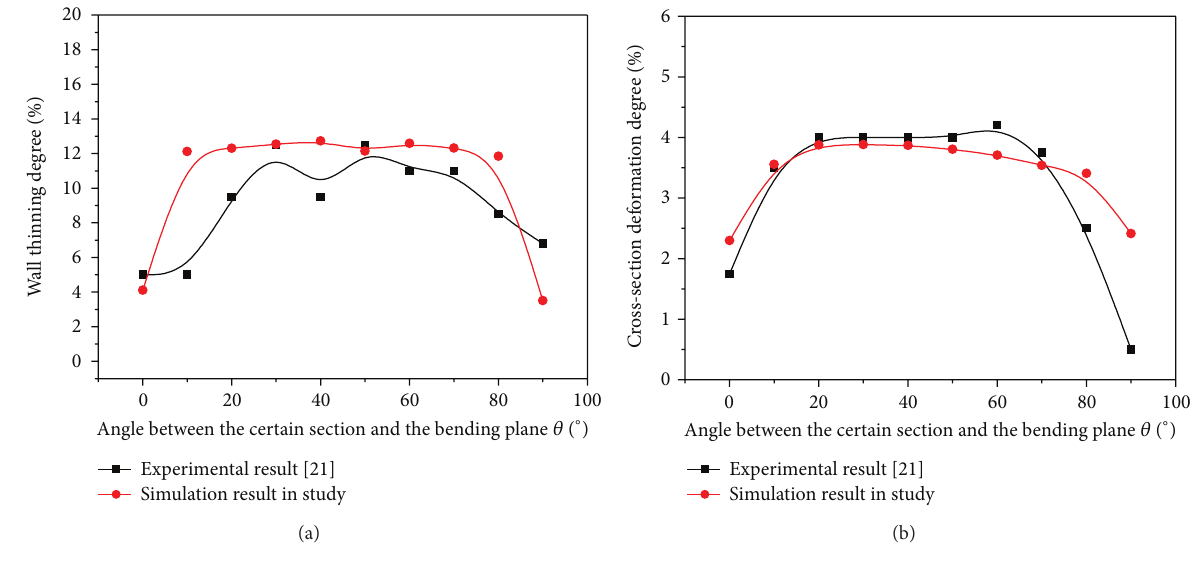
Figure 5: Comparison of simulation result with experimental result [21]: (a) wall thinning; (b) cross section deformation.